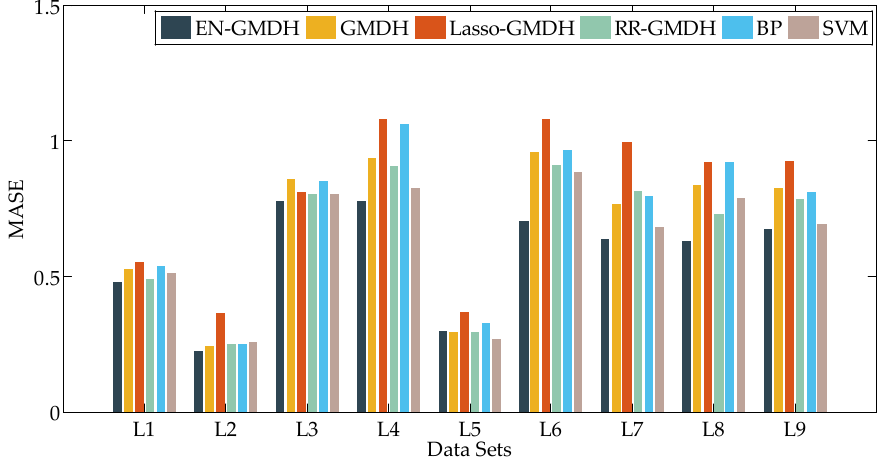
Figure 10. Results of Symmetric Mean Absolute Percentage Error (sMAPE) in L1 to L9.